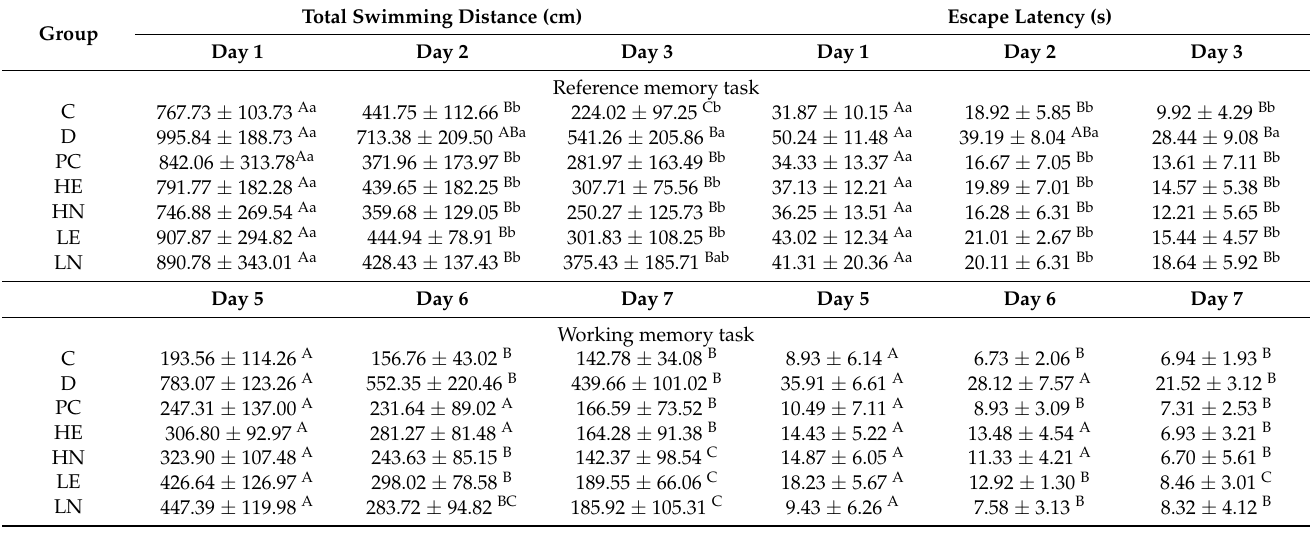
Data are presented as means ± standard deviation ( n = 6); C, control; D, DOCA-salt at a dose 25 mg/kg BW; PC, DOCA-salt with the administration of lisinopril at a dose 15 mg/kg BW; HE, DOCA-salt with the administration of black garlic extract at a dose of 100 mg/kg BW; HN, DOCA-salt with the administration of black garlic nanoemulsion at a dose of 100 mg/kg BW; LE, DOCA-salt with the administration of black garlic extract at a dose of 50 mg/kg BW; LN, DOCA-salt with the administration of black garlic nanoemulsion at a dose of 50 mg/kg BW. Values with different capital letters (A–C) in the same row for total swimming distance or escape latency and small letters (a,b) in the same column for total swimming distance or escape latency are significantly different ( p <